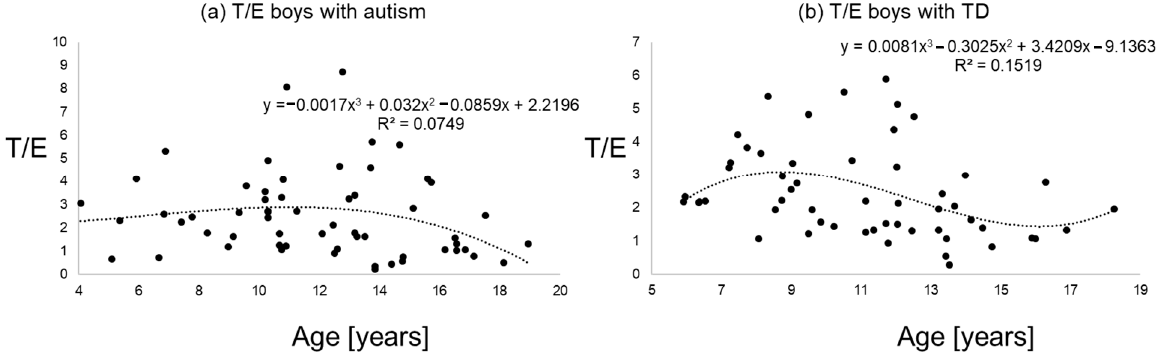
Figure 2. T/E ratios of boys with autism ( a ) versus typical development ( b ) the line shows a polynomial interpolation of third degree.